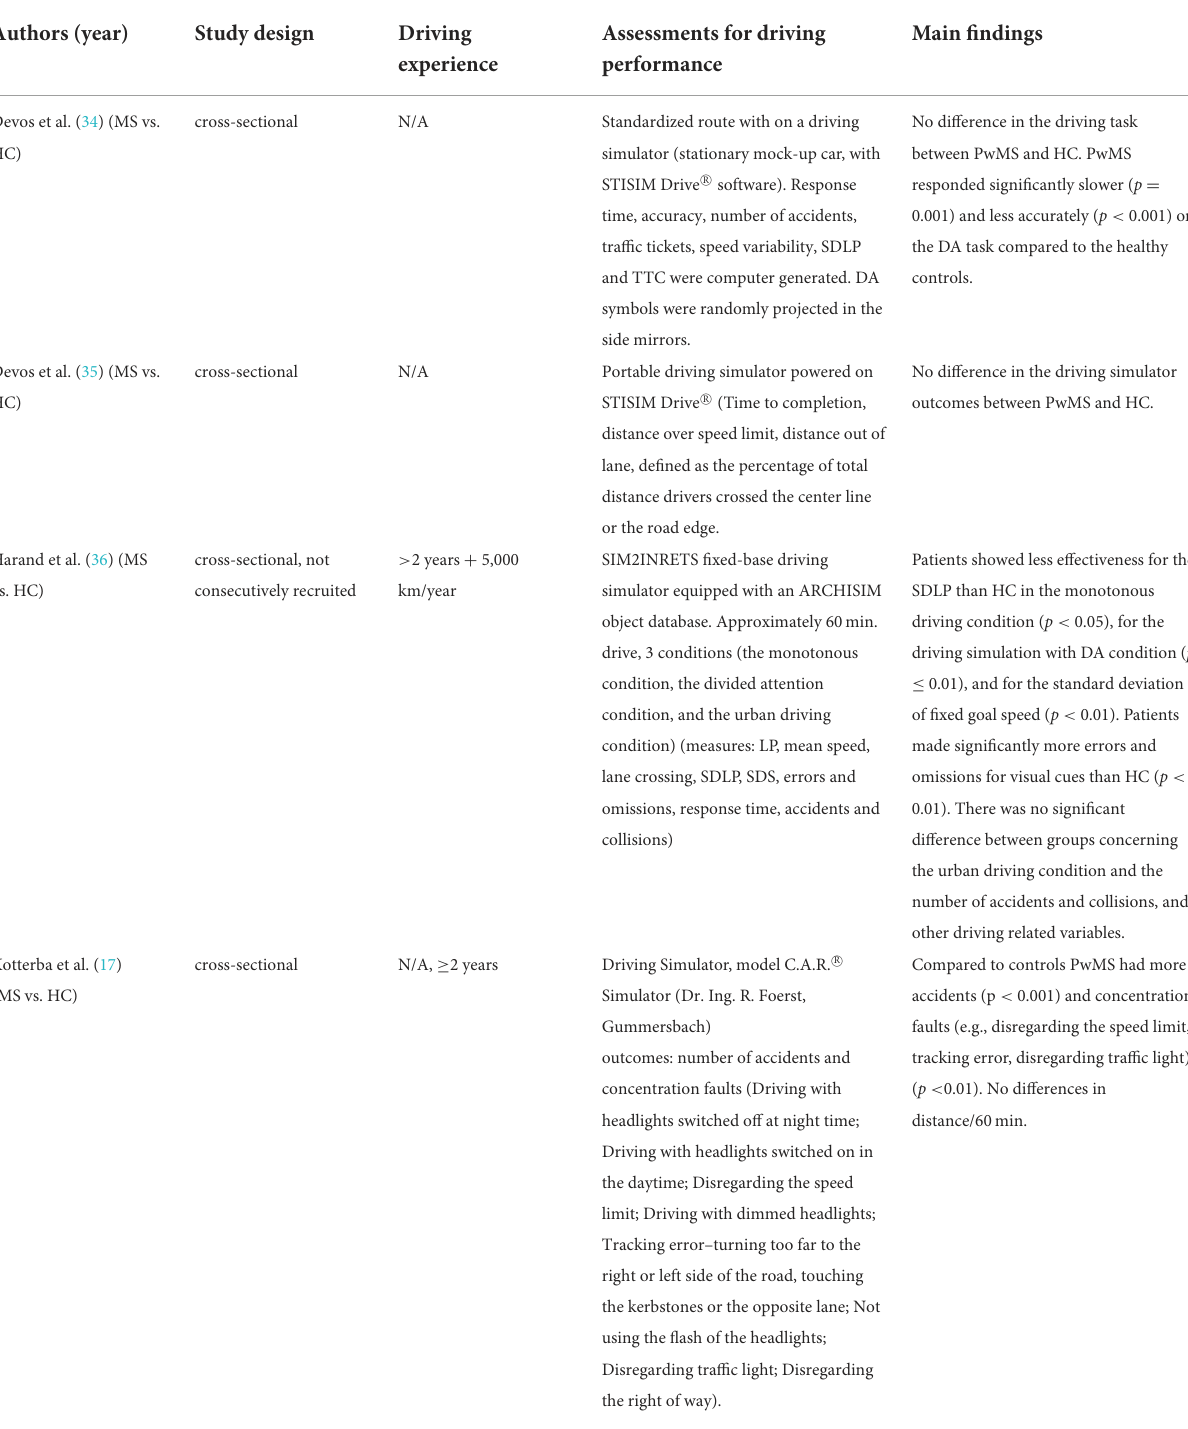
TABLE 2 Main results of driving simulator